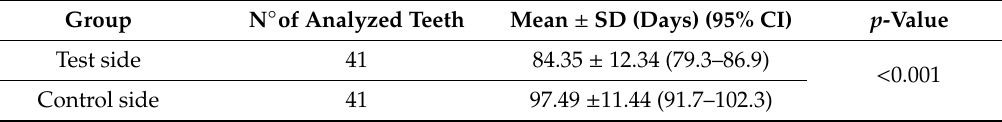
Table 1. Speed of tooth movement to accomplish space closure in the analyzed